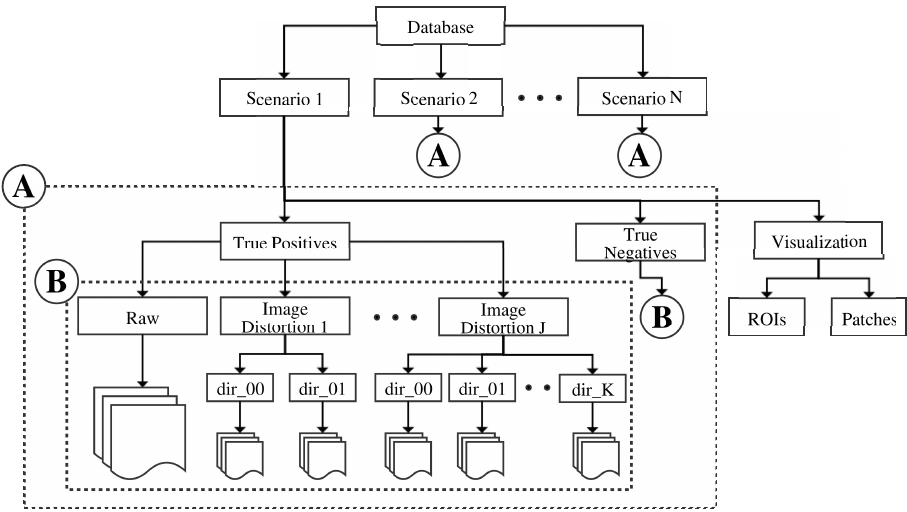
Figure 10. Underwater gestures database directory